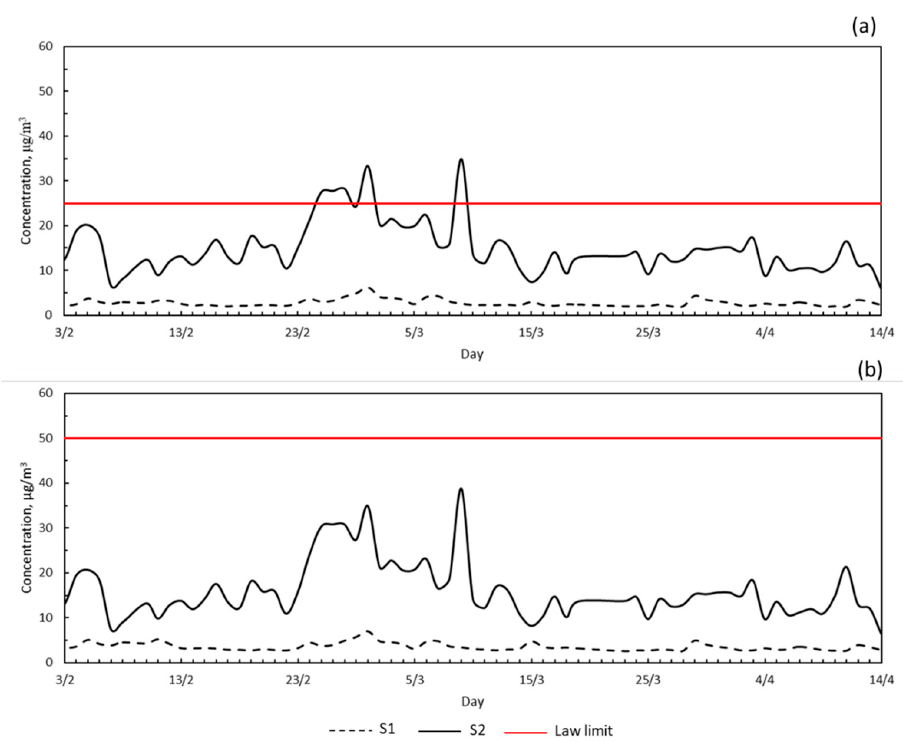
Figure 4. Daily average concentration of ( a ) PM 2.5 and ( b ) PM 10 measured in S1 (black dashed line) and S2 (solid black line) in the period 1 February 2021–15 April 2021. Red solid line represents the law limit concentration for PM 10 and PM 2.5 according to D.Lgs 155/2010.